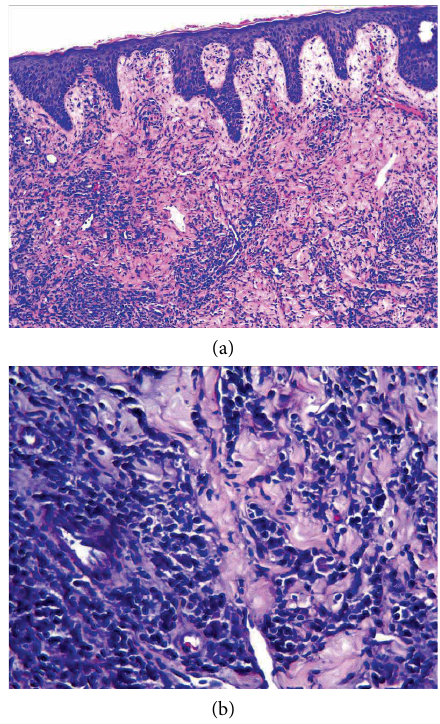
Figure 2: Biopsy of the nipple showed that epidermal hyperplasia, cutaneous protrusion, a migration of small amount of inflammatory cells, an infiltration of large number of cells around the blood vessels of the dermis (a). The inflammatory cells in the dermis were majorly lymphocytes and plasma cells (b). (H-E staining, original magnification: (a) ×100; (b) ×400)